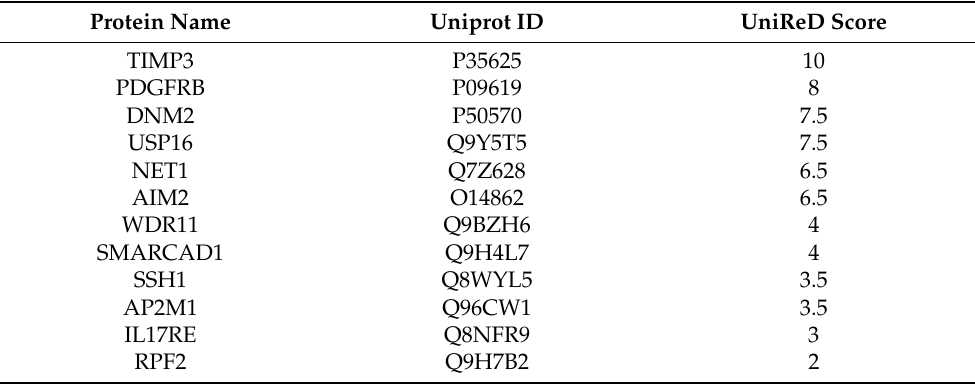
Table 2. Ranking of proteins of which the genes were included in the built classifying signatures according to their association to 10 genes known to be implicated in BrCa biology after analysis with